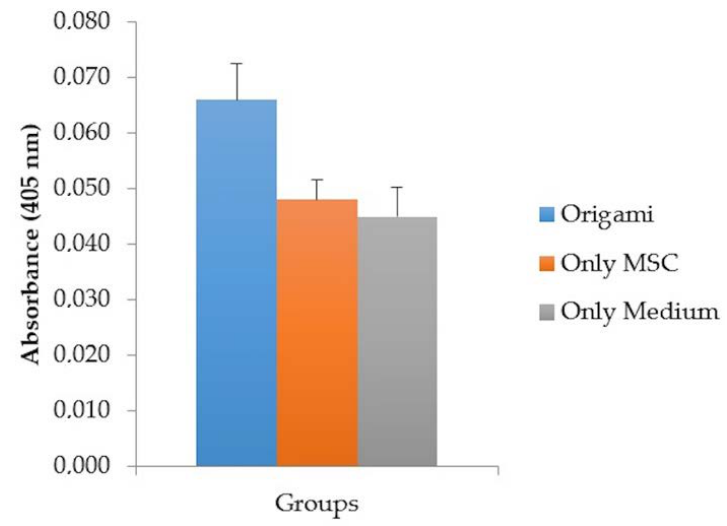
Figure 8. Osteogenic differentiation in the material and the control groups in terms of Alkaline Phosphate Yellow Liquid substrate system absorbance.